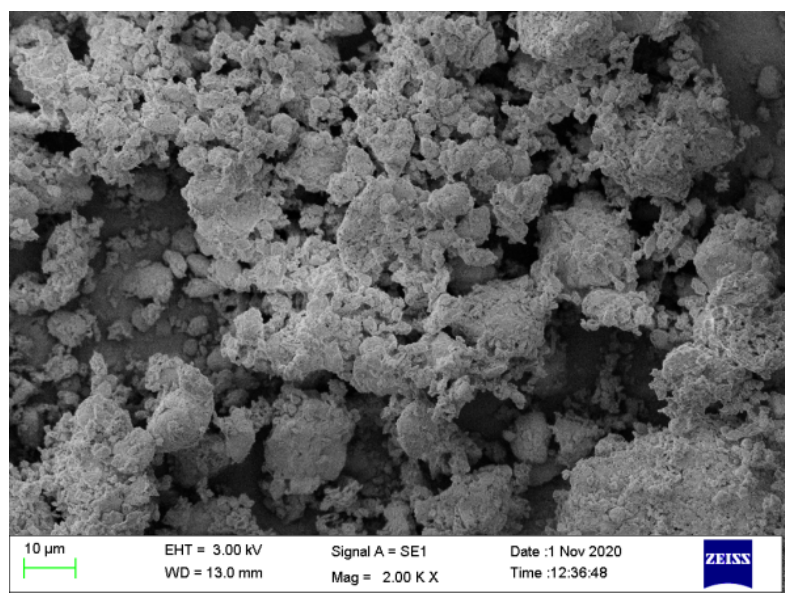
Figure 3. SEM image of the gangue.